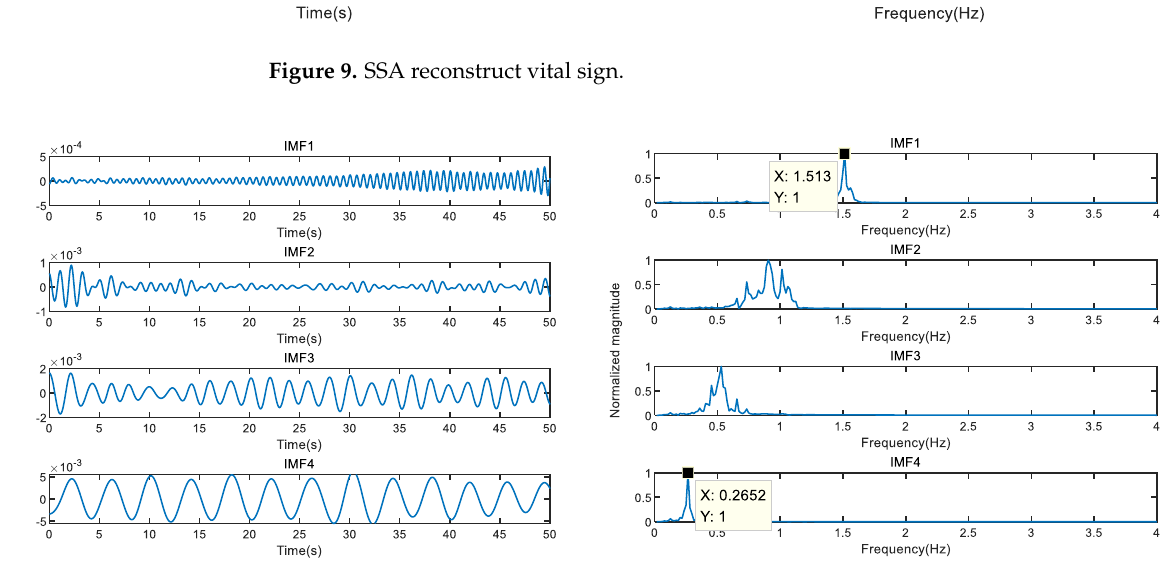
Figure 10. SSA-VMD result.